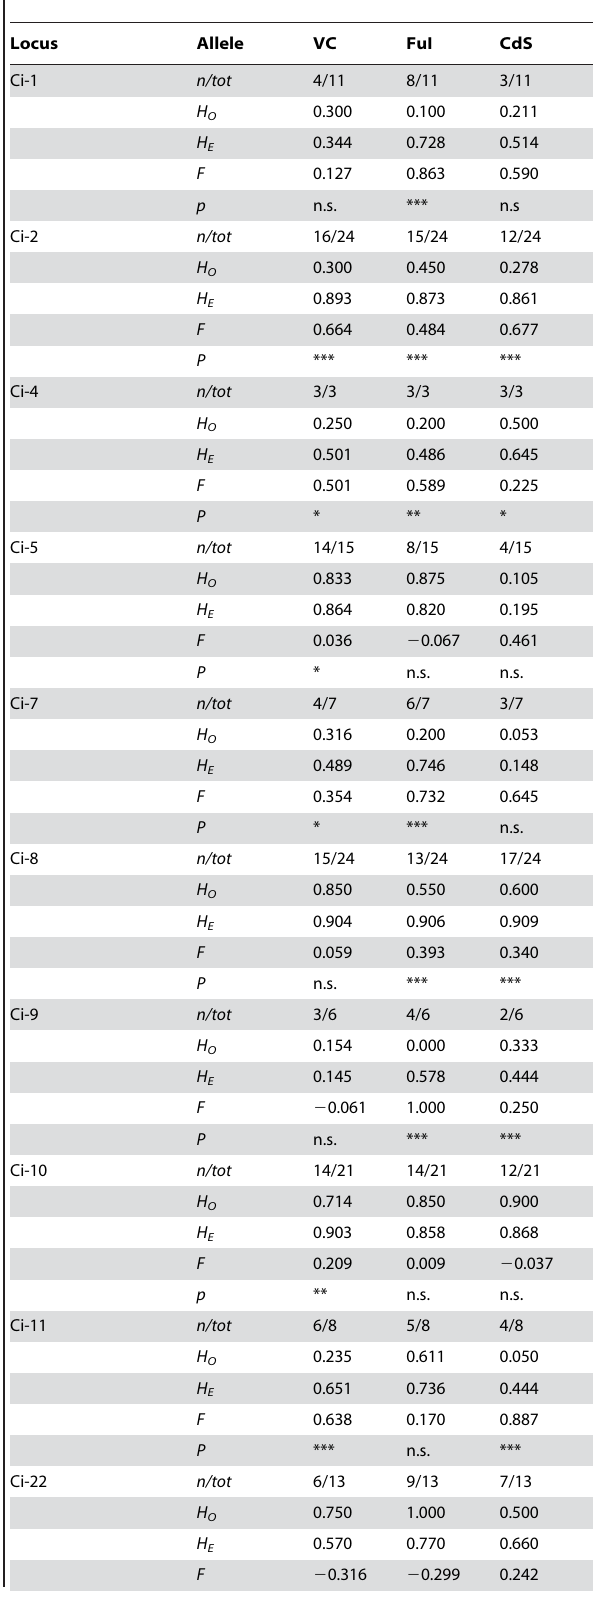
Table 3. cont. Locus Allele VC CdS